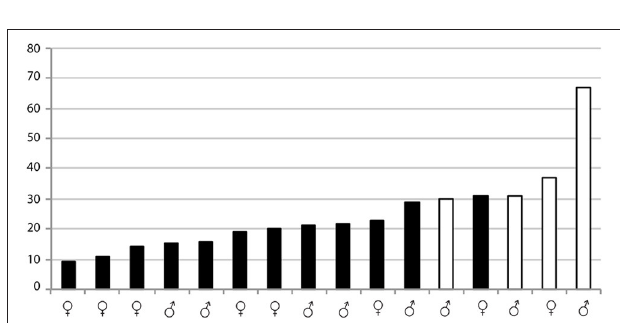
FIGURE 4 | Significant differences in microbiome richness of Trypanosoma cruzi infected and uninfected T. protracta adult individuals measured by Kruskal-Wallis rank test (chi-squared = 7.4558, df = 1, p -value = 0.006323). The numbers stand for the richness values. The black bars represent Trypanosoma cruzi negative samples. The white bars are Trypanosoma cruzi positive